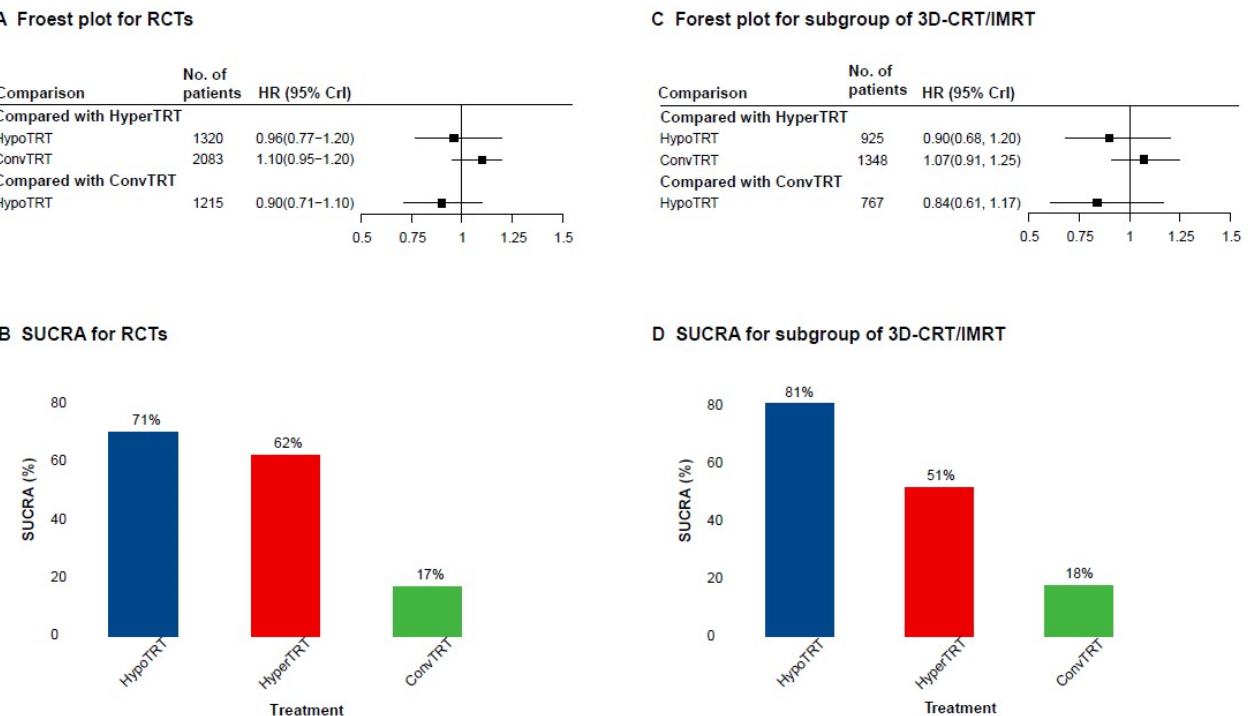
Figure 4. Forest plots for the hazard ratio and ranking plots with the surface under the cumulative ranking curve (SUCRA) in the network meta-analysis. ( A ), Forest plot for RCTs; ( B ), Forest plot for subgroup of 3D/CRT-IMRT; ( C ), SUCRA for RCTs; ( D ), SUCRA for subgroup of 3D-CRT/IMRT. Abbreviations: RCT, randomized controlled studies; HR, hazard ratio; CrI, credible interval; HypoTRT, hypofractionated thoracic radiotherapy; ConvTRT, conventional fractionated thoracic radiotherapy; HyperTRT, hyperfractionated thoracic radiotherapy; 3D-CRT, three-dimensional conformal radiotherapy; IMRT, intensity-modulated radiotherapy; SURA, surface under the cumulative ranking curve.